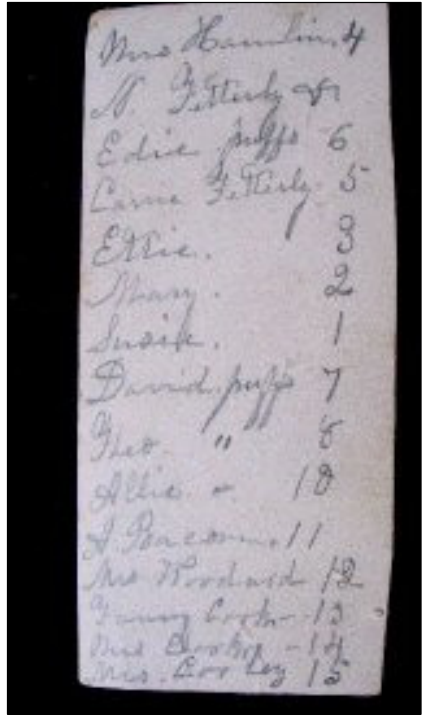
Figure 2. List of names with Hair